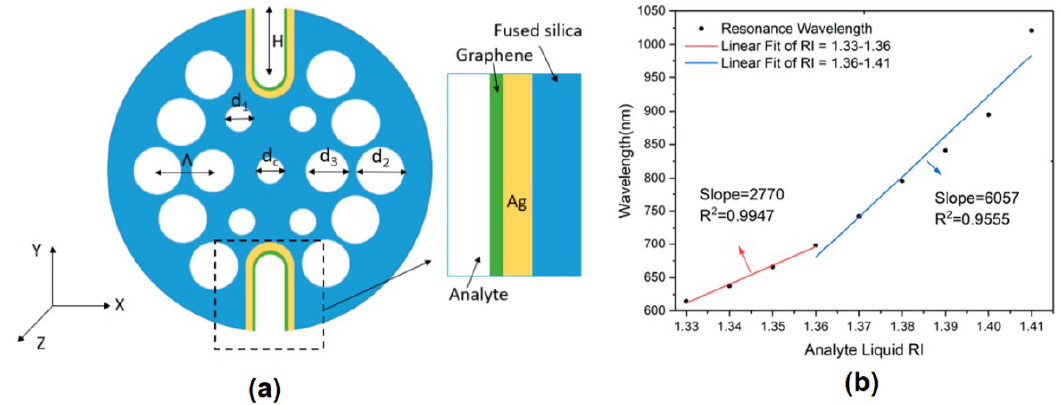
Figure 14. ( a ) Schematic of the designed Ag–Graphene coated photonic crystal fiber (PCF)–SPR sensor. ( b ) The relationship between the resonant wavelength and the analyte’s refractive index varies from 1.33 to 1.41 (adapted with permission from Reference [59], copyright